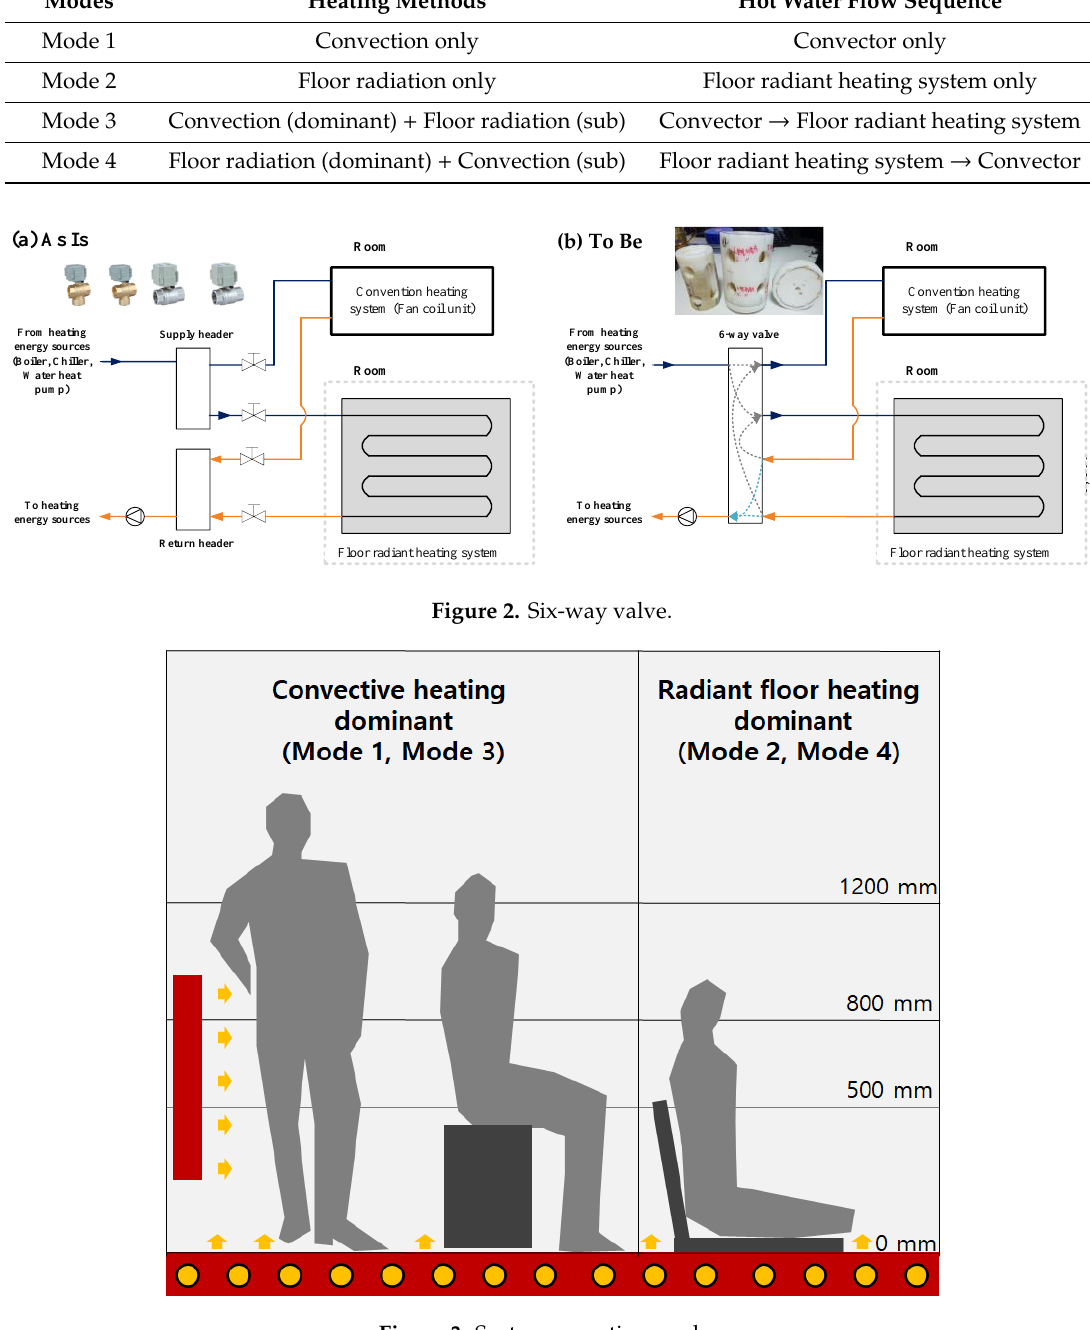
Figure 3. System operating modes. 2.3. Indoor Thermal Comfort Indicator In this study, PMV was used as an indoor thermal comfort indicator. The advantage of PMV is that it can rationally evaluate an indoor thermal environment considering the environment’s elements and the condition of the occupants. The ASHRAE and ISO standards suggest using PMV and the predicted percentage of dissatisfied (PPD) respondents as comfort indicators in an indoor environment [17,18]. The PMV can be calculated using equations (1)–(5). In this study, the metabolism of humans was set at 1.1 MET, and indoor clothing was set to 1.0 clo. The PMV and PPD are calculated using the air temperature taken at different heights. However, the other environmental factors were measured based on 1200 mm.